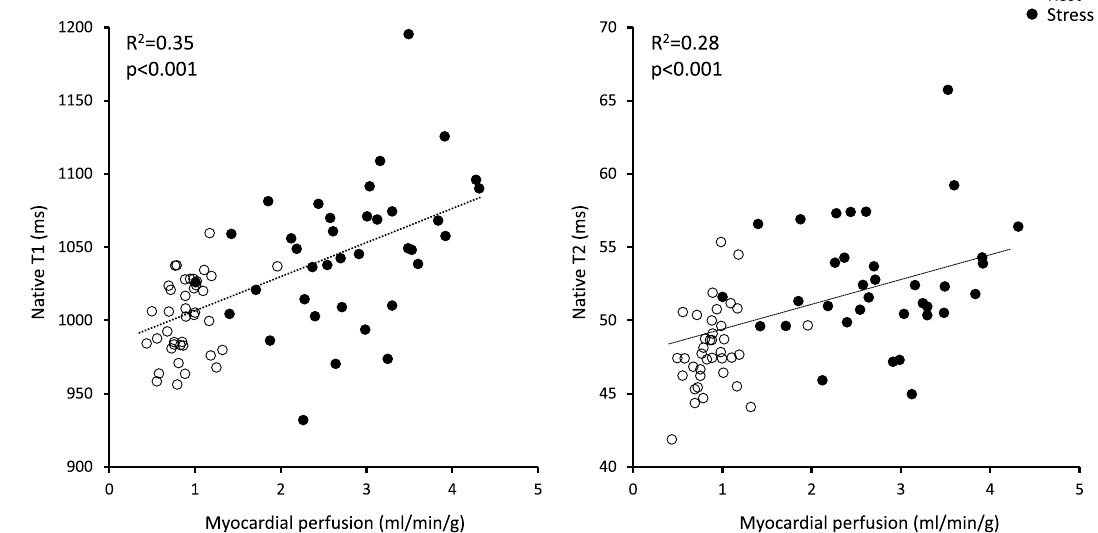
Figure 3. Relationship between rest and stress native T1 and T2 and absolute myocardial perfusion. Scatterplots comparing native T1 and T2 with absolute rest (white) and stress (black) myocardial perfusion.